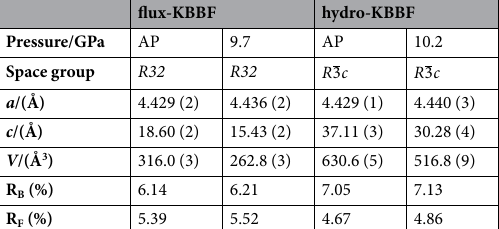
Table 1. The refined structure parameters of KBBF.